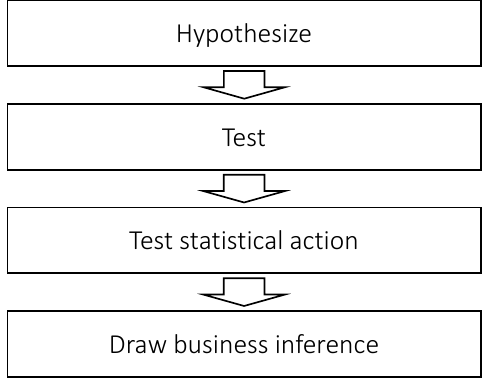
Figure 1. HTAB (Hypothesize, Test, Action, Business)